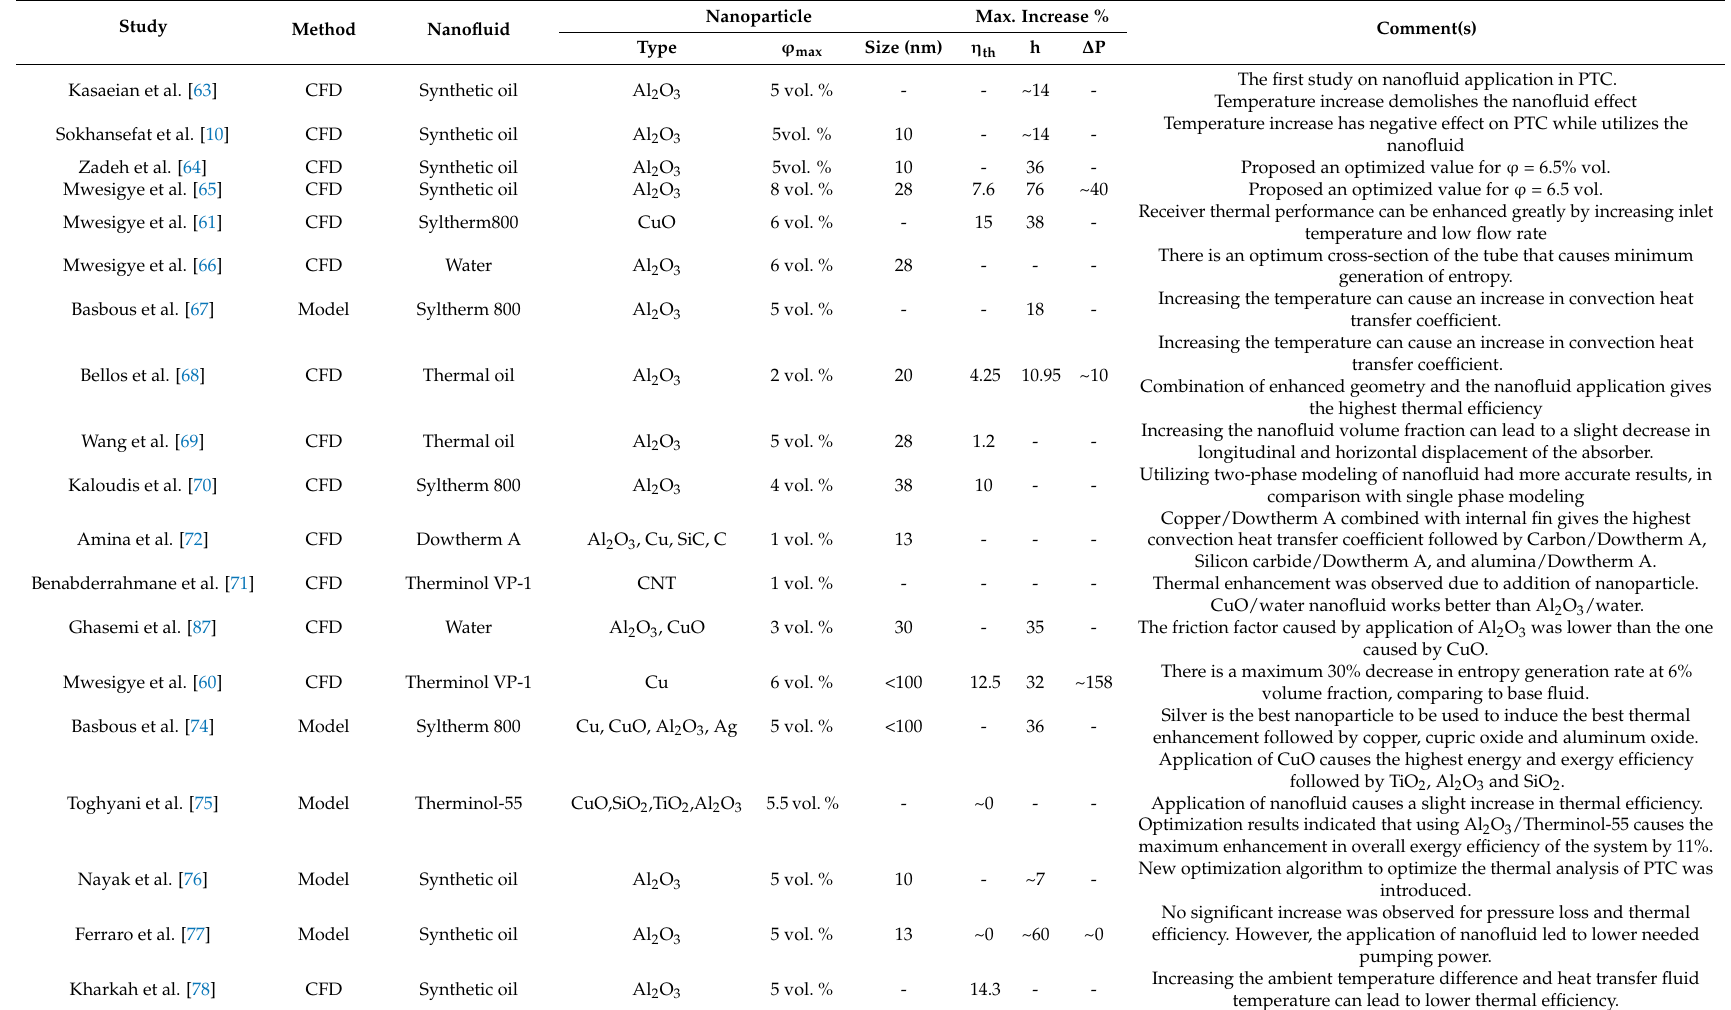
Table A2. Summary of numerical studies conducted on the nanofluid application in